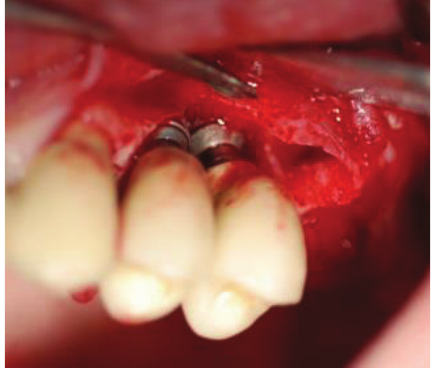
Figure 1: The baseline periapical radiograph indicated a deep interproximal peri-implant bone lesion.